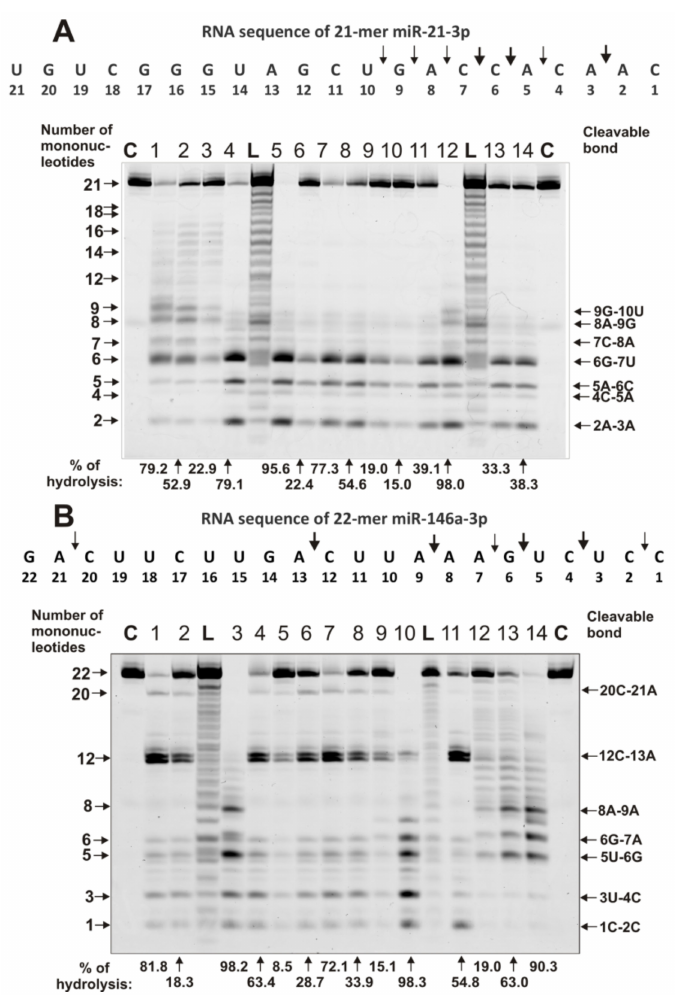
Figure 5. The patterns of hydrolysis of oligonucleotides Flu-miR-21-3p ( A ) and Flu-miR-146a-3p ( B ) by preparations of 0.6 µ M IgGs for 1 h of incubation from sera of 14 different MS patients. The products of the cleavage were detected due to the fluorescent residue (Flu) on the 5’-ends of the oligonucleotides. Lane C corresponds to ONs incubated in the absence of Abs, whereas Lane L corresponds to lengths of oligonucleotide markers. The lengths of the products, numbers of IgGs, and the percentage of microRNA hydrolysis by each IgG preparation are shown in panels ( A , B